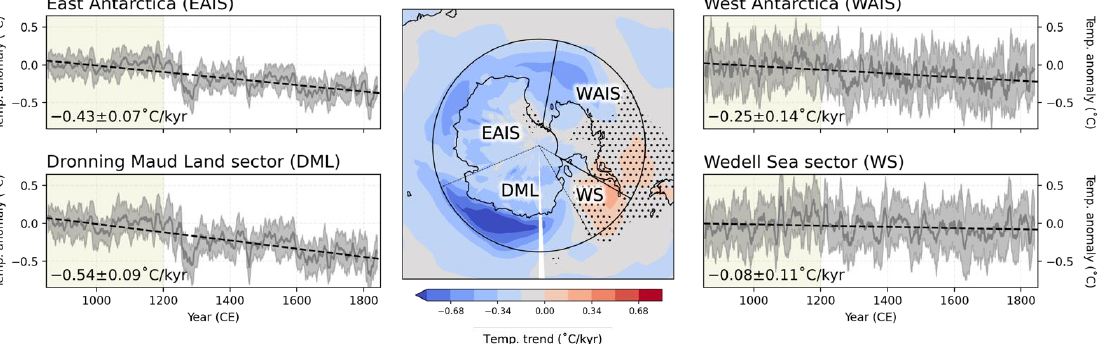
Figure 6. Regional temperature evolution in West Antarctica (WAIS), East Antarctica (EAIS), and the Wedell Sea (WS) and Dronning Maud Land (DML) sectors of EAIS in LME full forcing simulations. Timeseries of ensemble mean (grey) tem- perature anomalies for each region were computed relative to the base period of 850 – 1200 CE (highlighted in beige), a 10- year rolling mean was applied, and the ensemble standard deviation is shaded in light grey. Map ( center ) shows the full ensemble mean LM (850:1850) linear trend; stippling indicates areas where the ensemble standard deviation is greater than the trend.